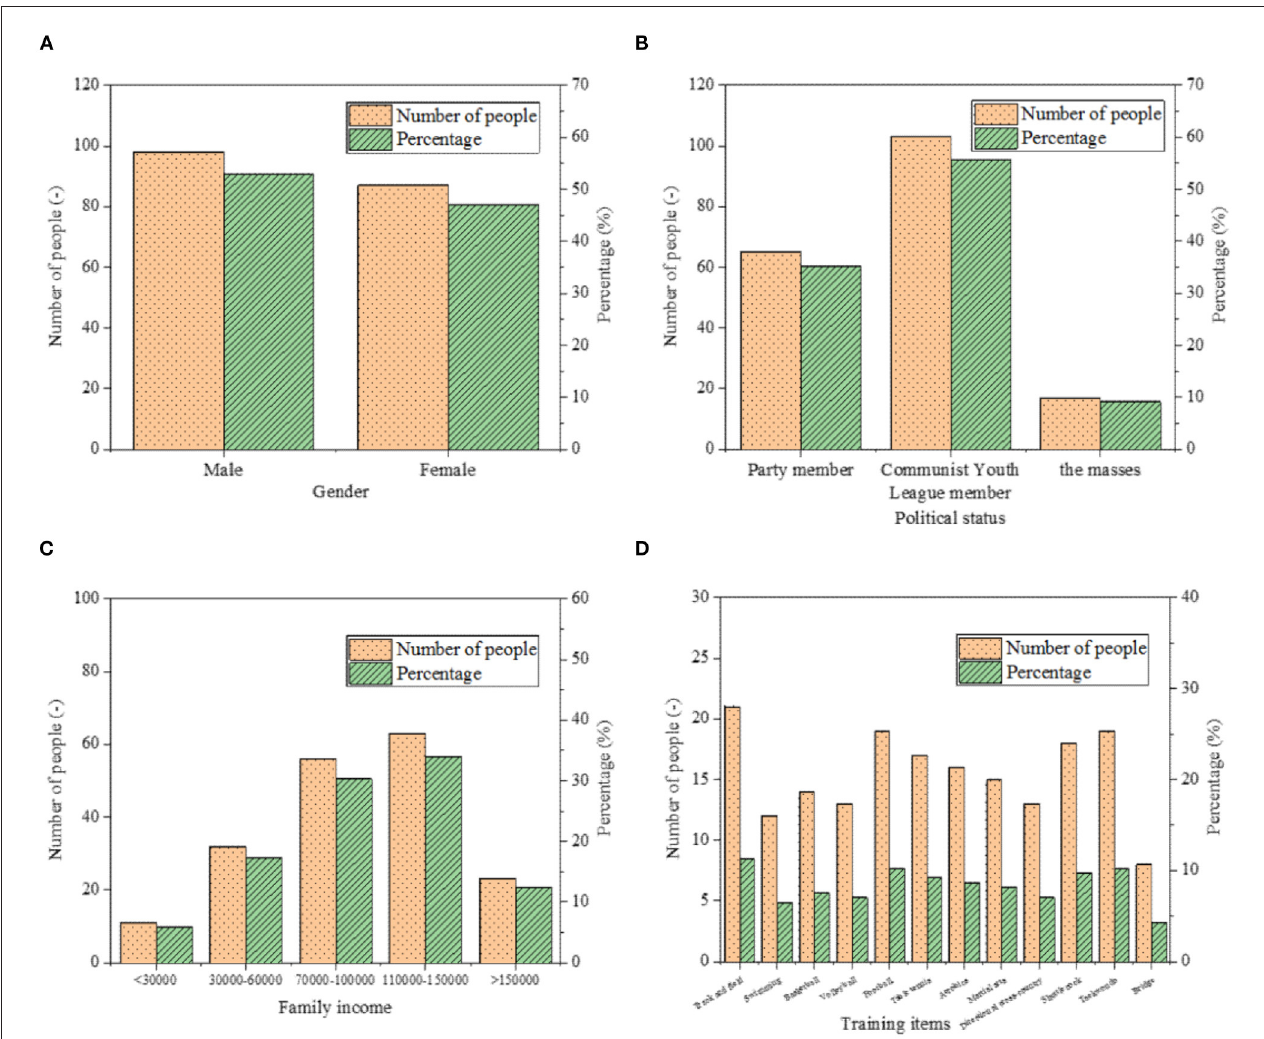
FIGURE 5 | Statistics of the basic situation of the investigated college athletes: (A) gender; (B) political status; (C) family income, and (D) training program.